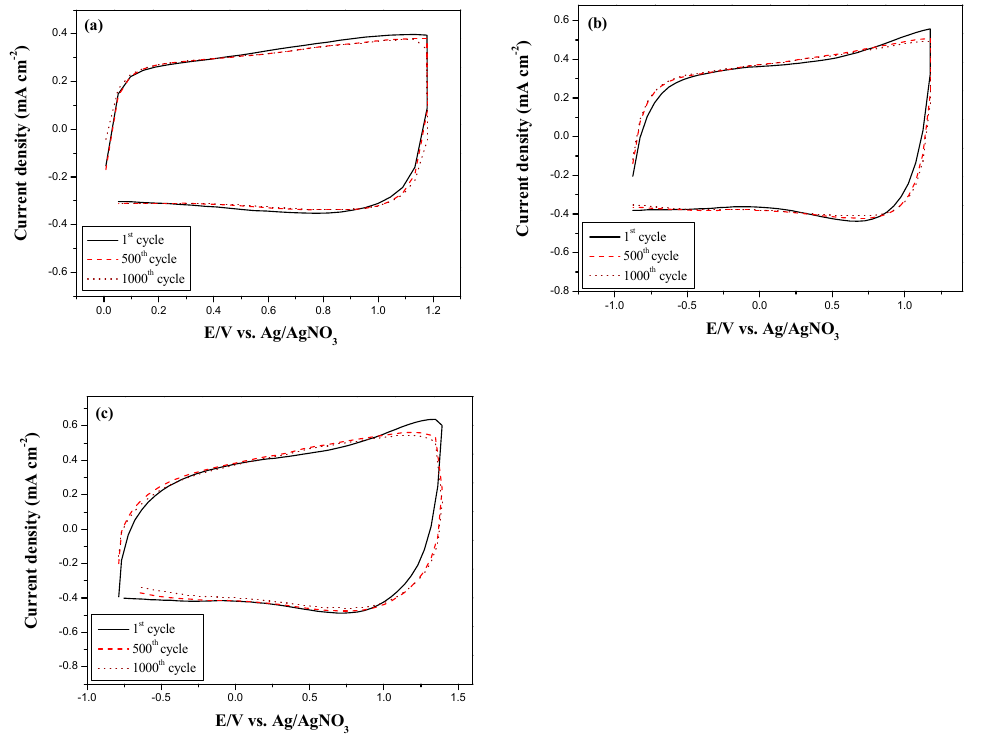
Figure 11. Cyclic voltammograms of ( a ) PInc/PMMA-PC-ACN-LiClO 4 /PEDOT-PSS; ( b ) P(Inc- co -bT)/PMMA-PC-ACN-LiClO 4 /PEDOT-PSS; and ( c ) PbT/PMMA-PC-ACN-LiClO 4 /PEDOT-PSS ECDs as a function of repeated with a scan rate of 500 mV s − 1 at 1st, 500th and 1000th cycles. The optical memory effect is a crucial character for ECDs [32]. The optical memory of PInc/PMMA-PC-ACN-LiClO 4 /PEDOT-PSS, P(Inc- co -bT)/PMMA-PC-ACN-LiClO 4 /PEDOT-PSS, and PbT/PMMA-PC-ACN-LiClO 4 /PEDOT-PSS ECDs was evaluated by giving potential for 1 s for each ECD showed adequate optical memories in a neutral state of P(Inc- co -bT) film, the transmittance change of P(Inc- co -bT)/PMMA-PC-ACN-LiClO 4 /PEDOT-PSS ECD is less than 1% in the reduced states of P(Inc- co -bT) film. However, in the oxidized state of P(Inc- co -bT) film and in the reduced state of PEDOT-PSS film, the P(Inc- co -bT)/PMMA-PC-ACN-LiClO 4 /PEDOT-PSS ECD is less stable than that in the reduced state of P(Inc- co -bT) film and oxidized state of PEDOT-PSS film, but the transmittance change of P(Inc- co -bT)/PMMA-PC-ACN-LiClO 4 /PEDOT-PSS ECD is less than 5%, the optical memory of P(Inc- co -bT)/PMMA-PC-ACN-LiClO 4 /PEDOT-PSS ECD are compared to other reported polymer-based ECDs [33,34], indicating P(Inc- co -bT)/PMMA-PC-ACN-LiClO 4 /PEDOT-PSS ECD shows adequate optical memory in bleaching and coloring states.